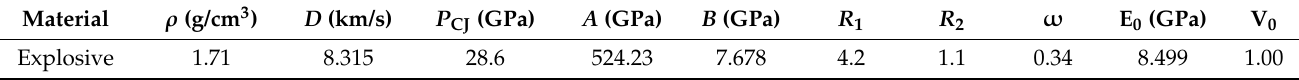
Table 4. Material parameters of the JH-2 explosive.